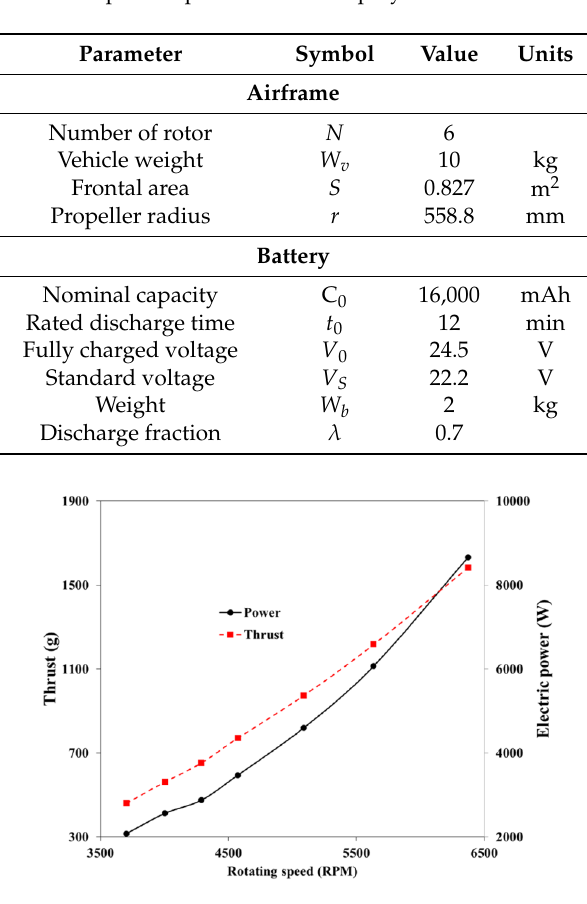
Figure 4. Multirotor UAV used for numerical predication and experimental validation. Table 1. Important parameters of employed multirotor UAV.